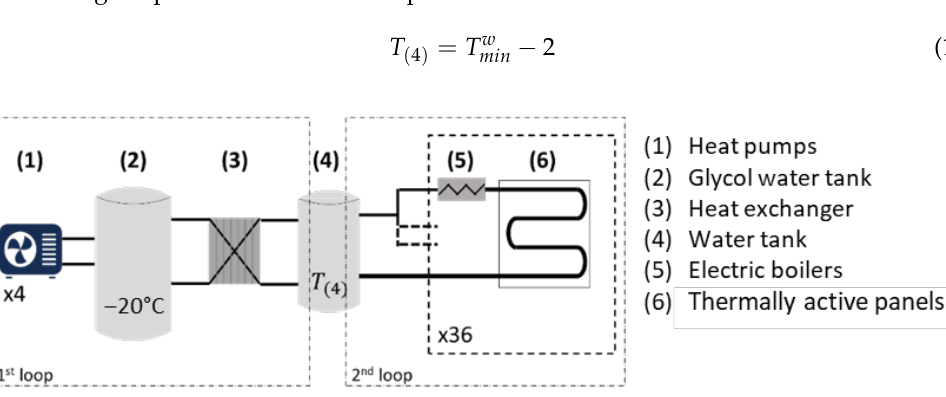
Figure 7. The temperature control loop of the hydronic panels.